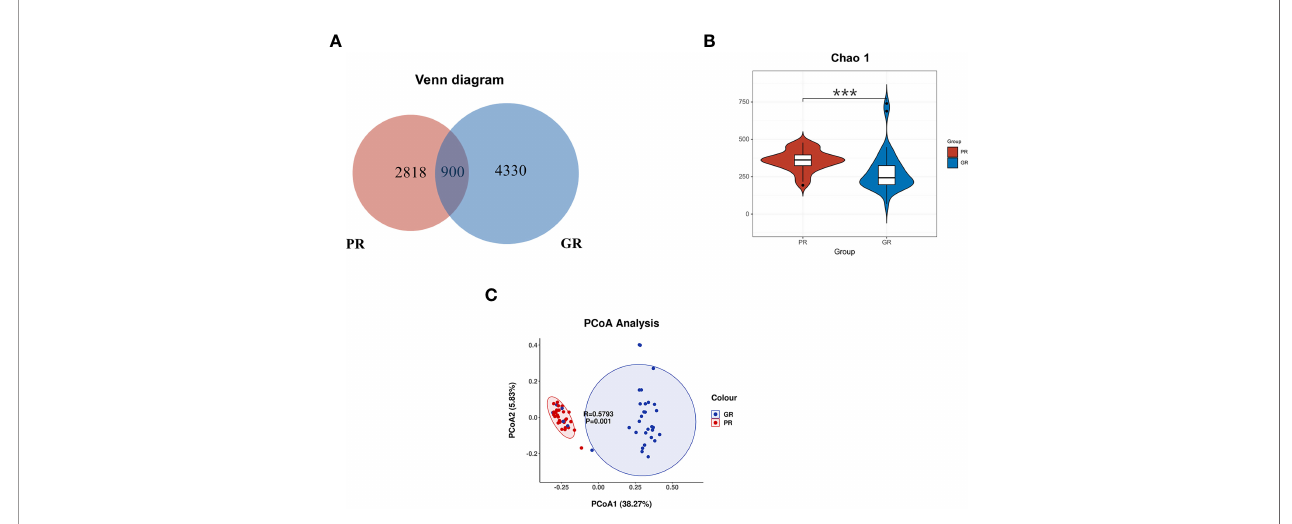
FIGURE 2 | Comparison of the bacterial structure between the PR and GR groups. (A) Venn diagram presents the ASV numbers. (B) a diversity analysis of GR and PR. Chao1 index (P = 0.00018) revealed the ASV count. (C) PcoA analysis indicated that the microbiome samples were clustered in two groups. * p < 0.05; ** p < 0.01; *** p < 0.001; **** p < 0.0001. PR, poor response; GR, good